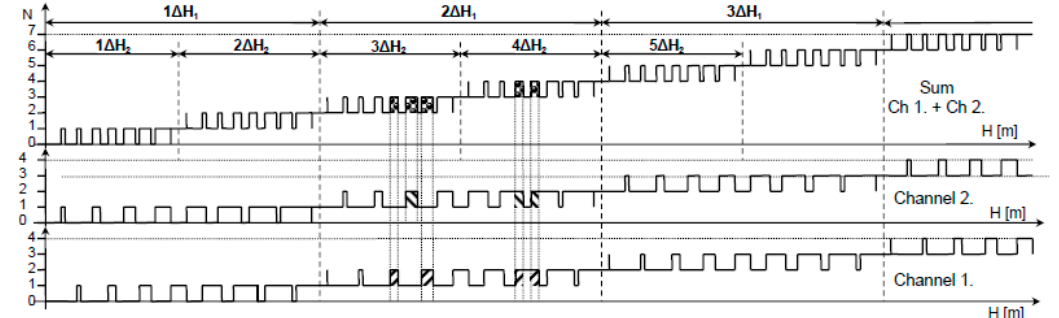
Figure 4. Height pulses creation in a double-channel radio altimeter.